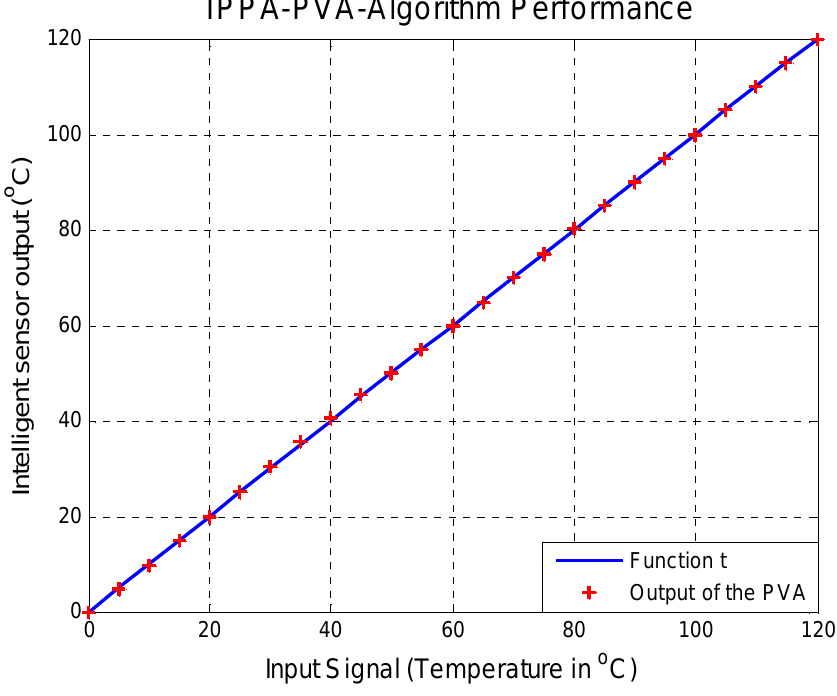
Figure 11. Improved algorithm performance with six readjustment points